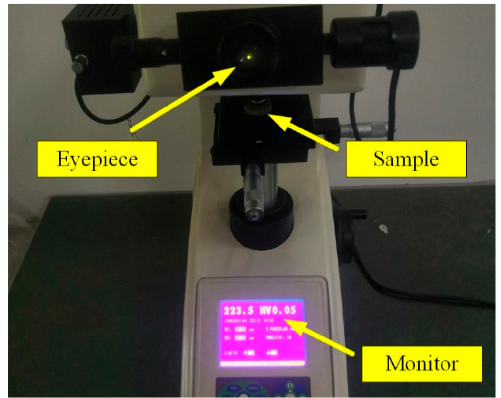
Figure 4. Micro-hardness measurement